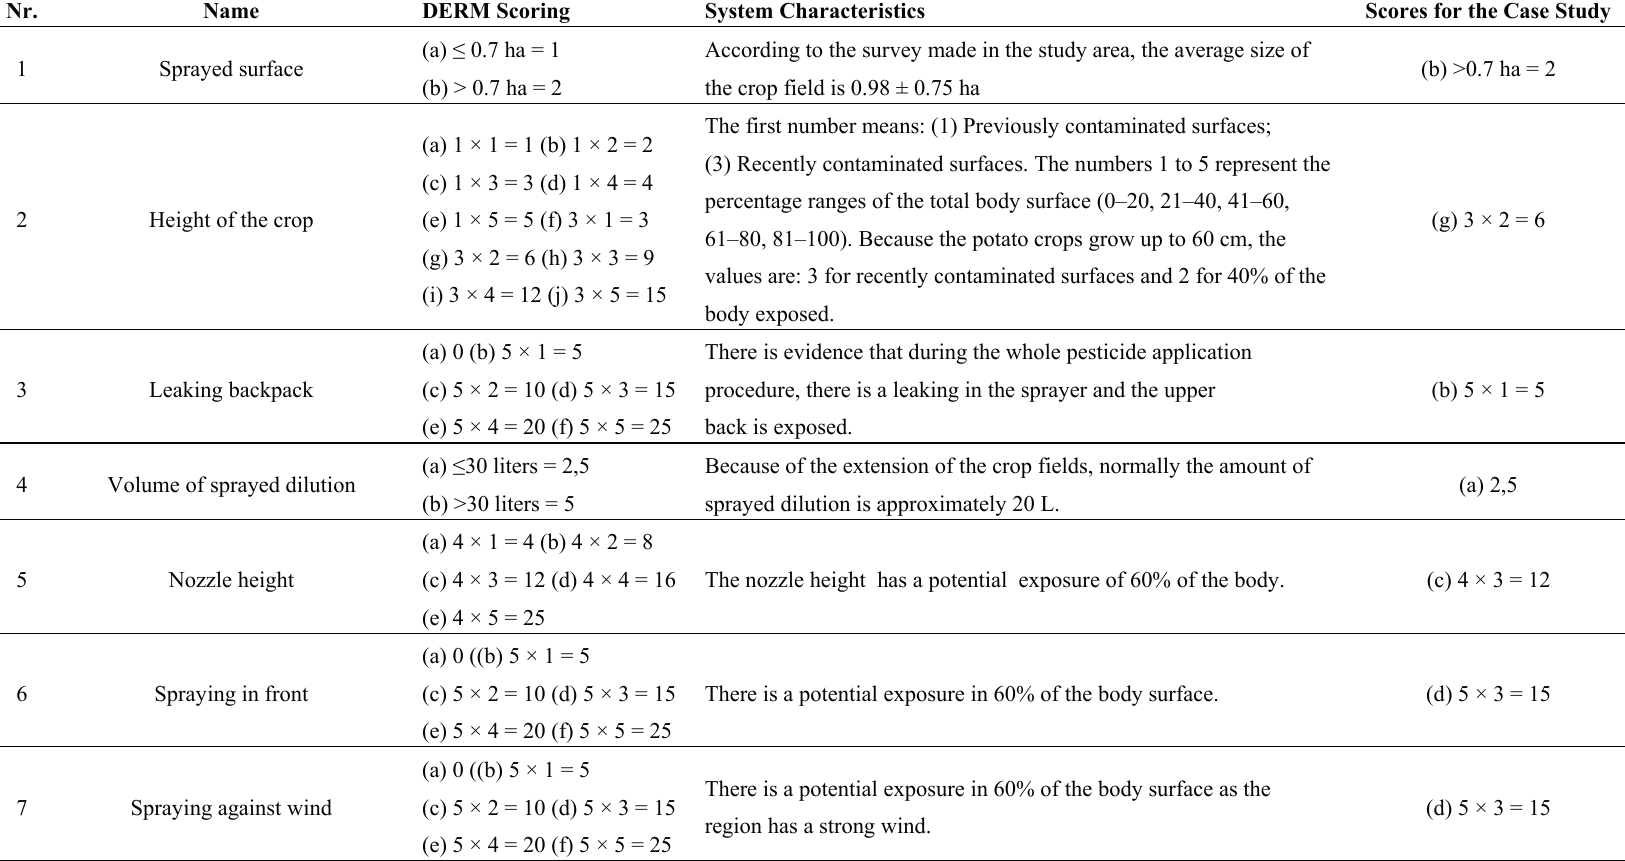
Table A1. DERM Scoring System for the Case